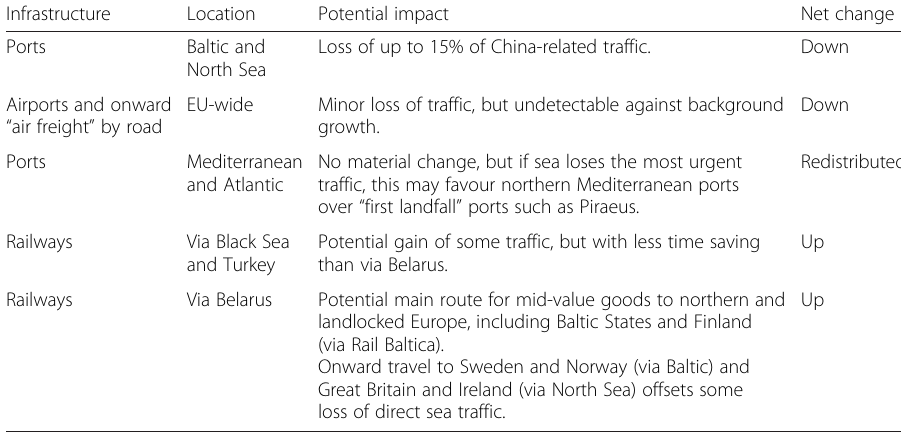
Table 2 Potential impacts on EU ports, airports and railways Infrastructure Location Potential